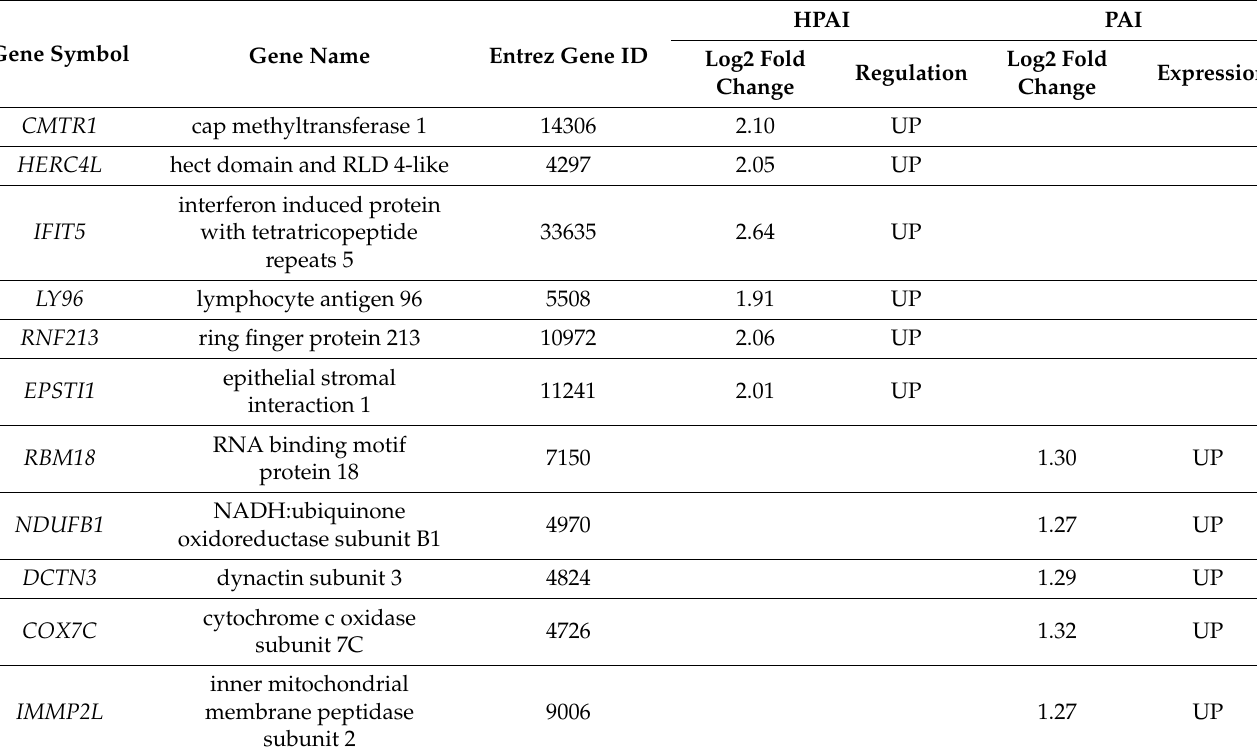
Table 3. Comparison of differential gene expression found between HPAI and LPAI datasets.